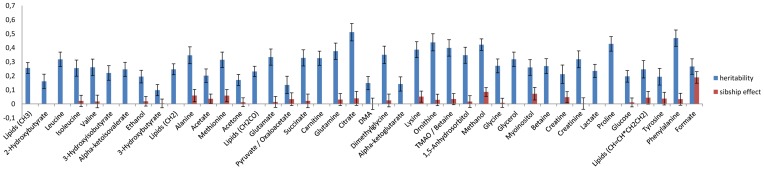
Heritability and sibship effects on the NMR metabolites.Figure shows the magnitude of heritability (H2) and sibship (household) effect estimates for each metabolic trait included in the ERF population.